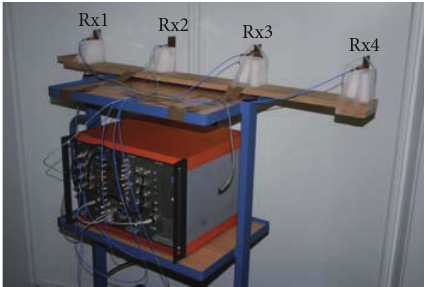
Figure 3: The fixed receiving antenna array with four vertical